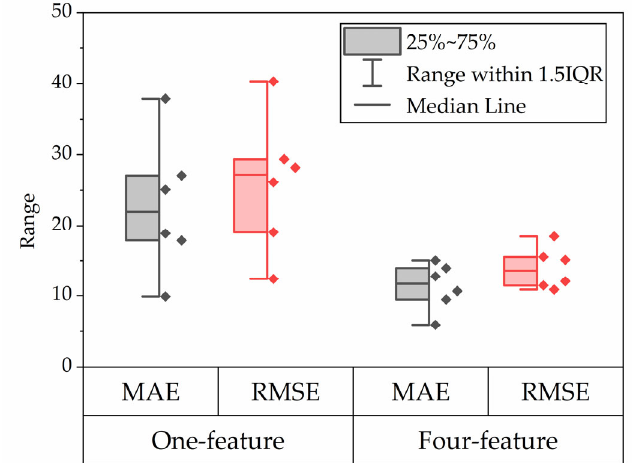
Figure 14. Half boxplot of mean absolute error (MAE) and RMSE of the one ‐ feature model and four ‐ feature model with the Iterative approach on test wells.